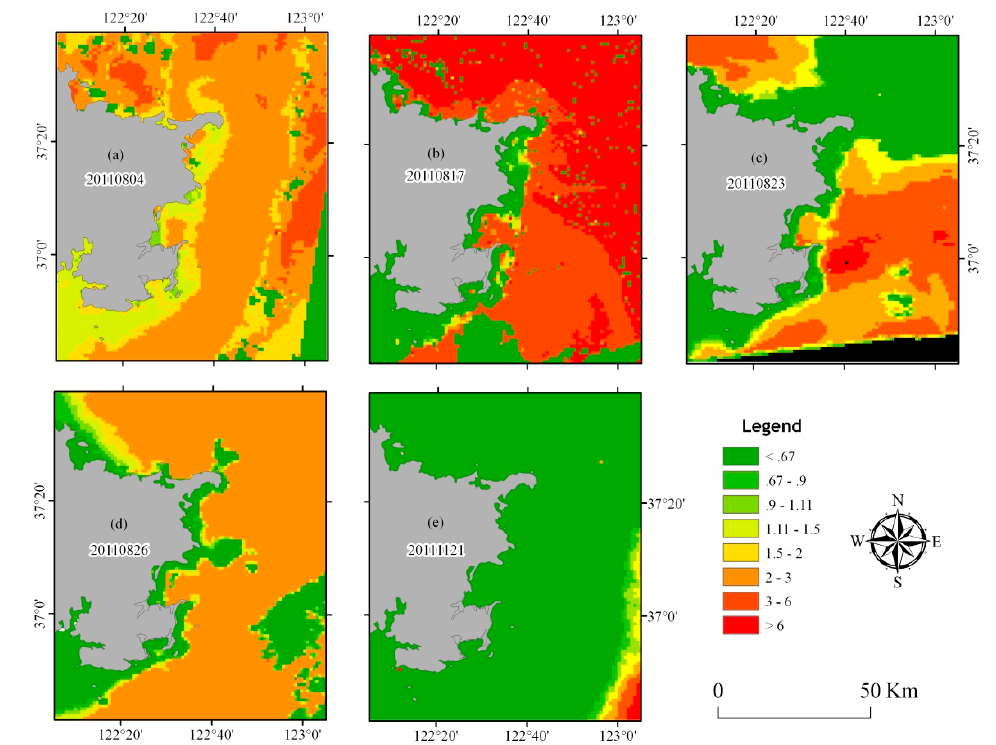
Figure 11. Time series variation characteristics of the kurtosis of surface particles before and after the passage of typhoon Muifa on August 8, 2011.